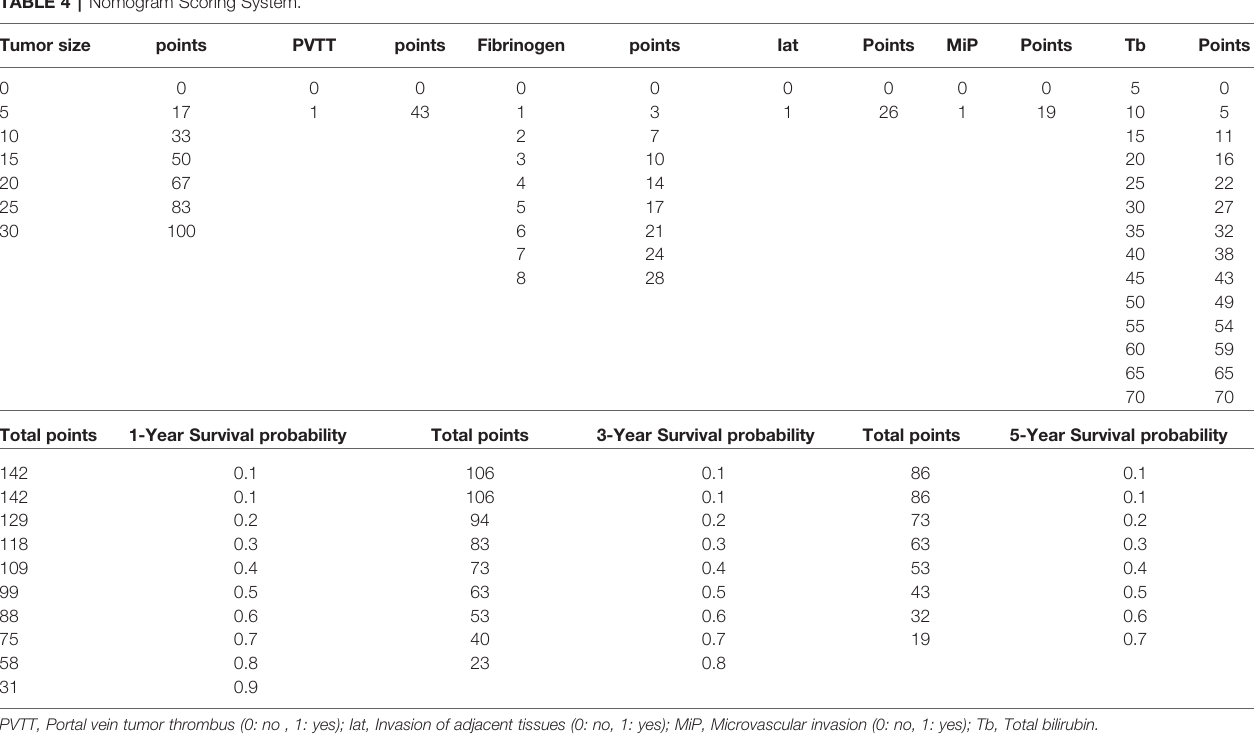
TABLE 4 | Nomogram Scoring